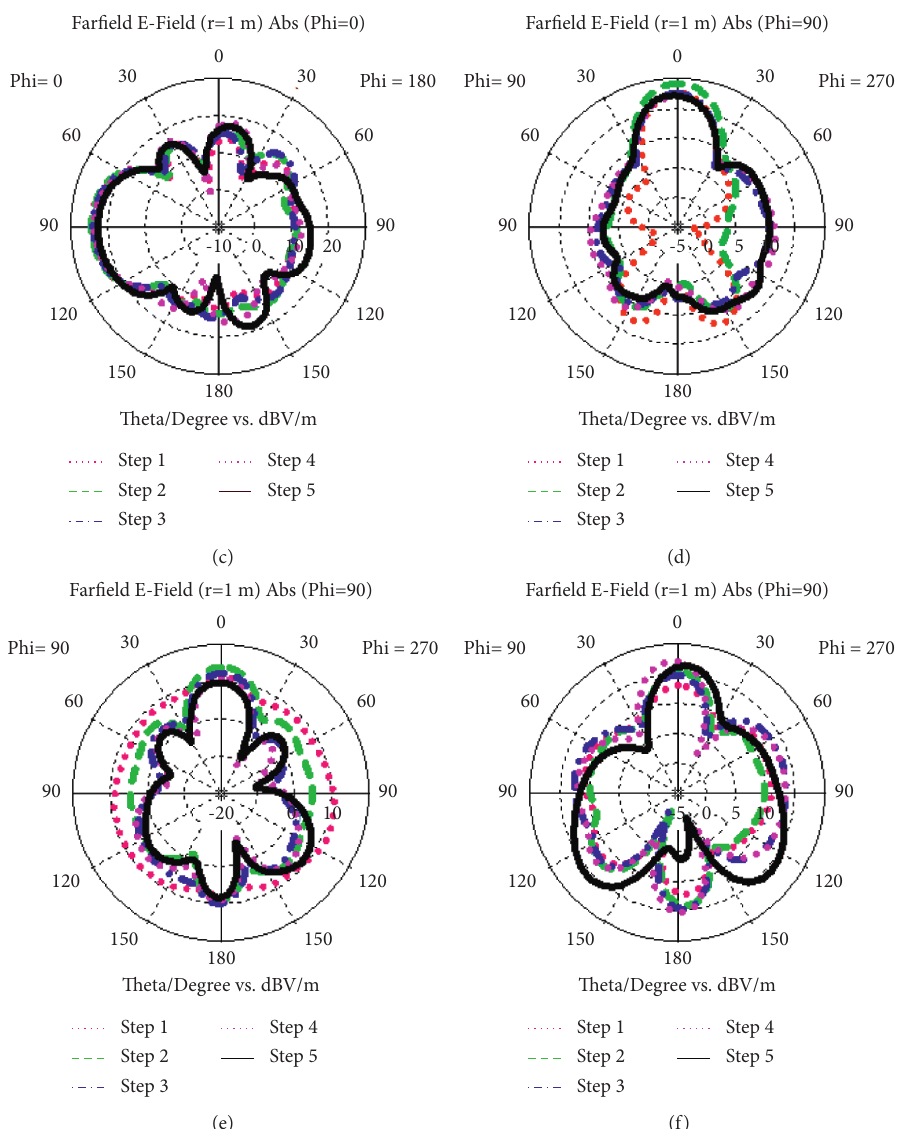
Figure 12: Electric field (E-field) for all the steps at Phi � 0 ° and 90 ° : (a) E-field (Phi � 0 ° ; 3.81GHz); (b) E-field (Phi � 0 ° ; 6.75 GHz); (c) E- field (Phi � 0 ° ; 13.86 GHz); (d) E-field (Phi � 90 ° ; 3.81GHz); (e) E-field (Phi � 90 ° ; 6.75GHz); (f) E-field (Phi � 90 ° ;